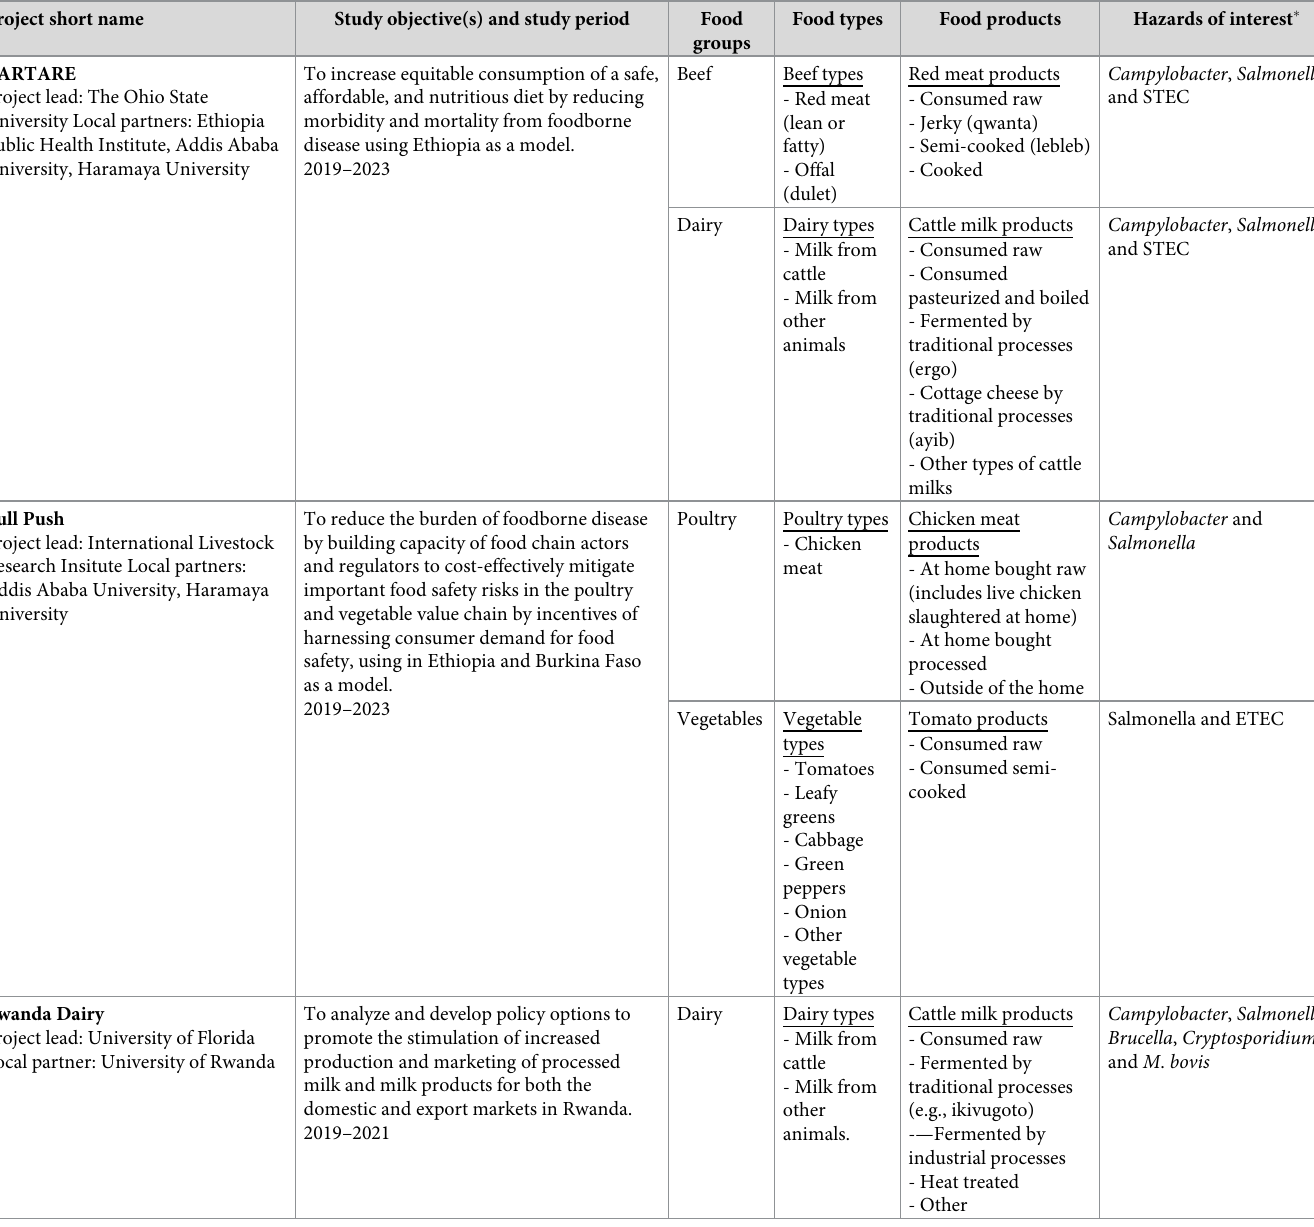
Table 1. Scope and objectives of three food safety projects in Africa and associated food classification schemes and